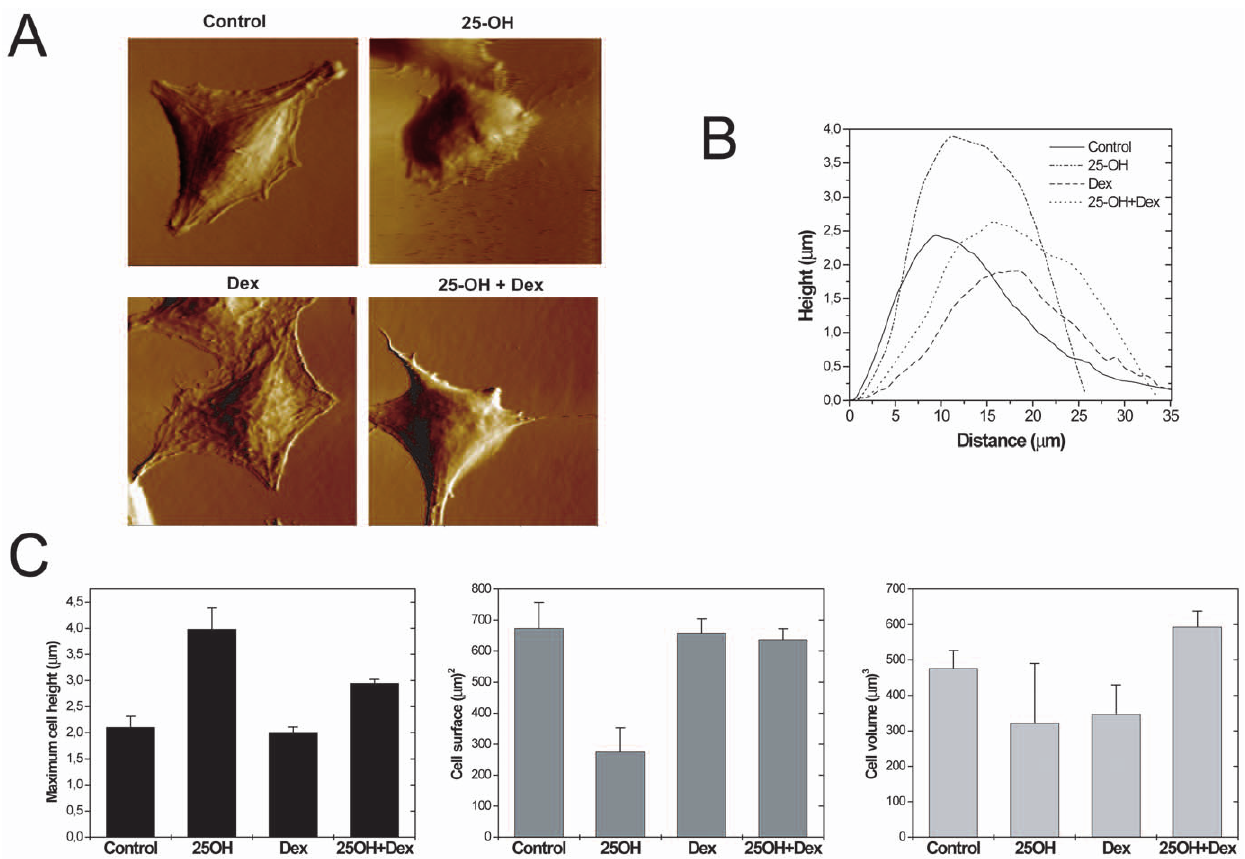
Figure 7. Alteration of oligodendrocytes morphology by 25-OH and Dex. A/ Representative AFM deflection images of living oligodendrocytes in culture medium. 158N cells were cultured on a matrix of collagen I during 24 h and then cells were incubated or not with 25OH (10 2 5 M) and/or Dex (10 2 6 M) during 24 h. The cells were then imaged with AFM in contact mode. This experiment was repeated three times, and typical images are presented here. Image scan size: 60 m m 6 60 m m. B/ Height profiles corresponding to the cross-sections of the same cells as in (A). C/ Histogram of the morphometric parameters, i.e. maximum cell height, cell surface and total cell volume of 158N cells, incubated or not. All averages are calculated from five